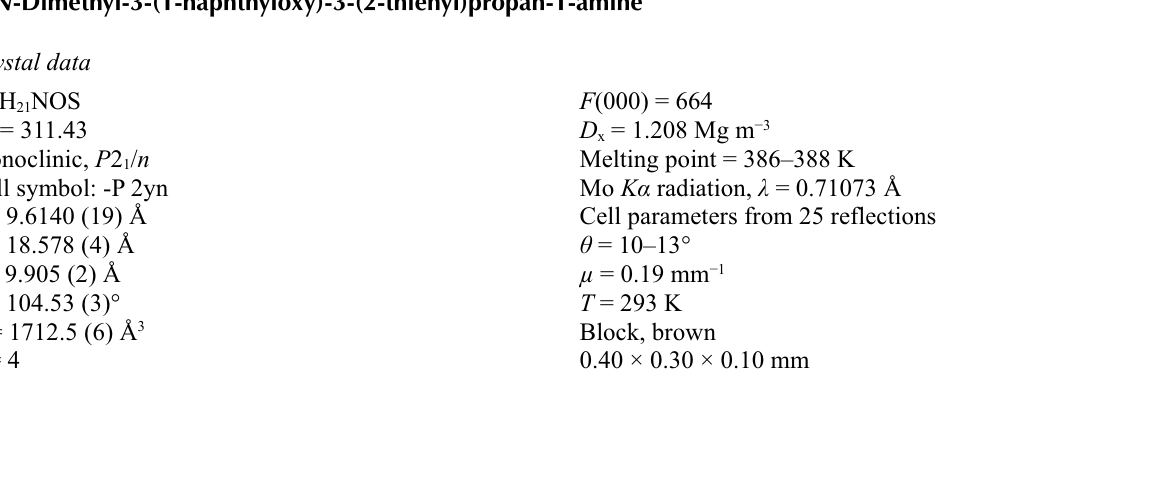
The crystal packing of (I) viewed along